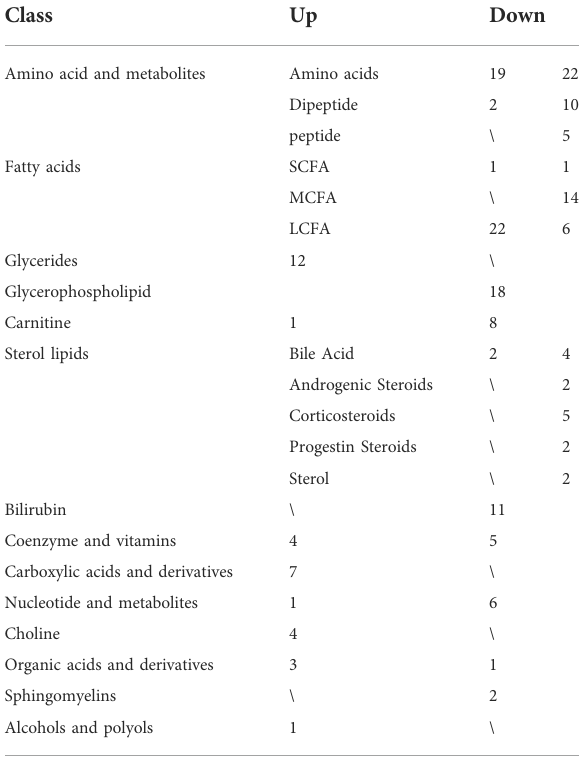
TABLE 3 Summary of different types of metabolites in COVID-19